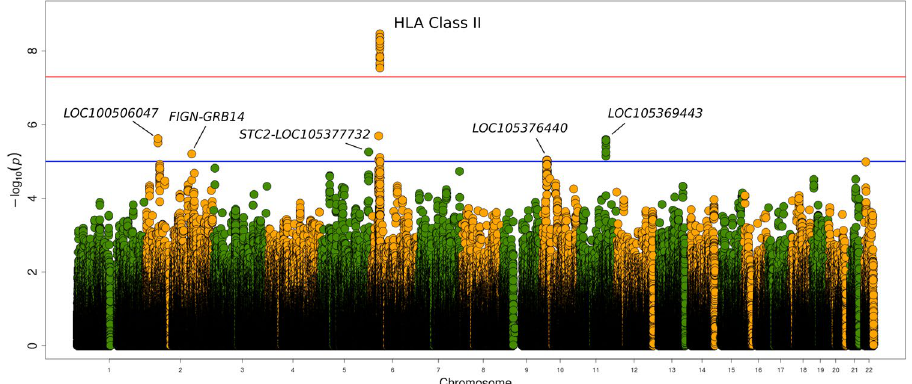
Figure 1. Manhattan plot representation of the results of this study. The − log10 of the p values are plotted against their physical chromosomal position. The red line represents the genome-wide level of significance (P < 5E-08). A less stringent threshold (p < 1E-05) is highlighted in